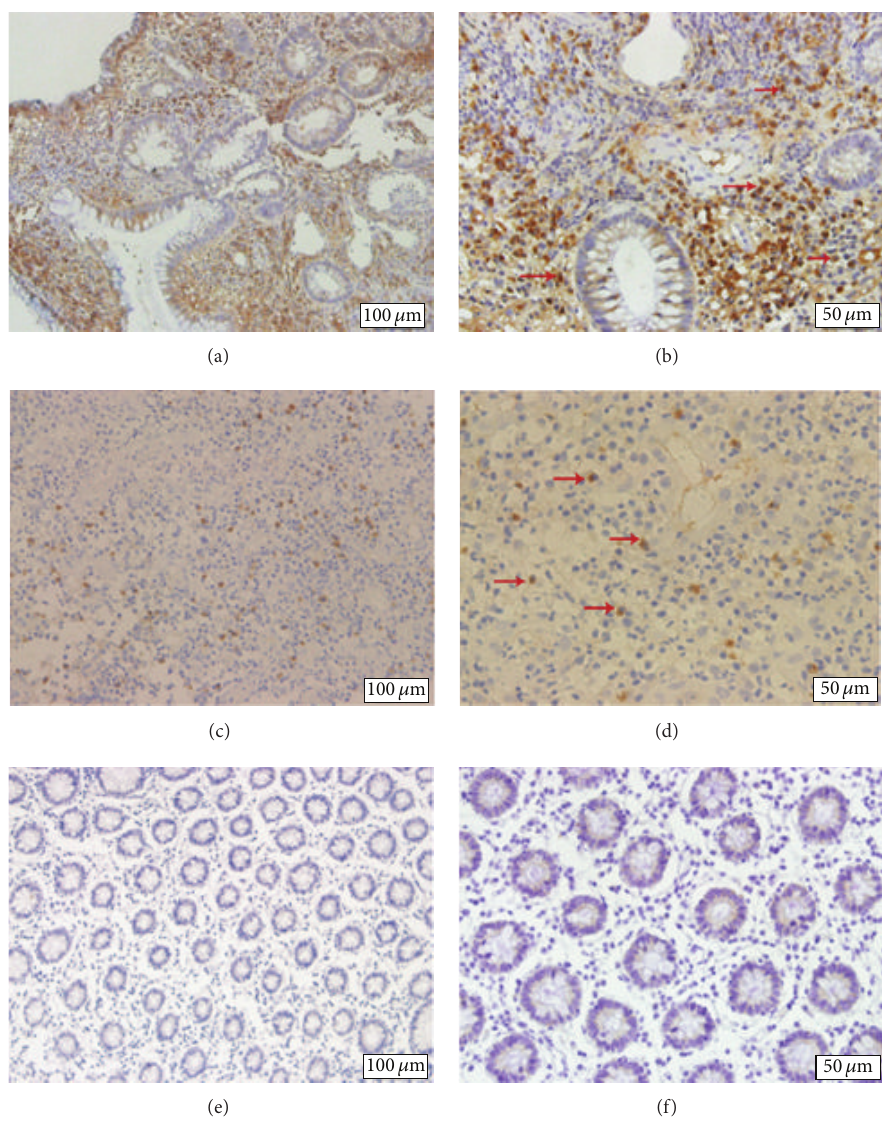
Figure 2: Photomicrographs of immunostaining for IL-35 in human colon from patients with UC (a and b), patients with CD (c and d), and healthy controls (e and f). No staining was found in the control group (e and f), and IL-35 was expressed in infiltrating immune cells (morphologically resembling lymphocytes) but not in epithelial cells. The staining was mostly cytoplasmic, and red arrows depicted immunoreactive positive cells. The number of IL-35-expressing cells in inflamed colonic tissue of patients with UC was higher than in CD patients’ tissue. Original magnification: (a), (c), (e) × 200; (b), (d), (f) ×